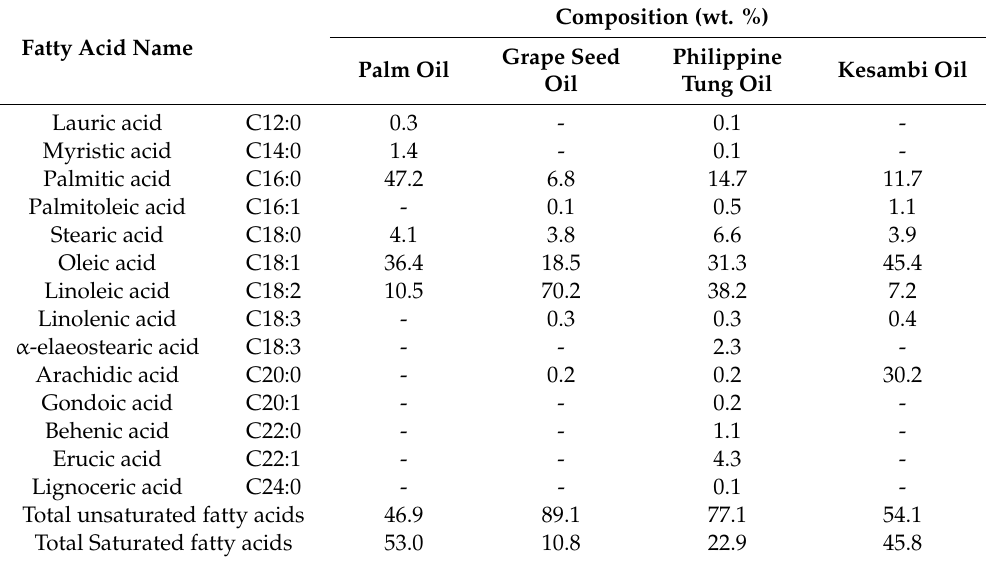
Table 3. Fatty acid composition of